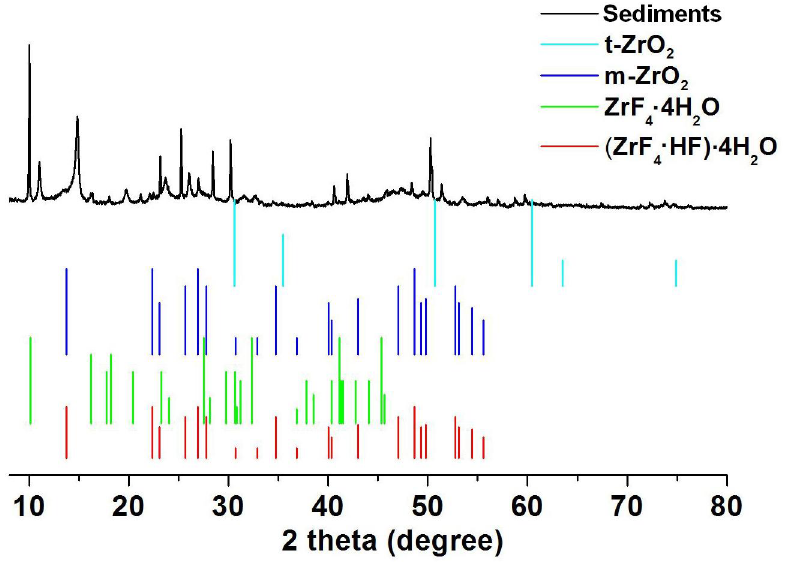
Fig 5. X-ray diffraction (XRD) patterns of the sediments formed in the solutions from the 40% hydrofluoric (HF) acid-immersed groups. The diffraction peaks can be well indexed to t -ZrO 2 (JCPDS